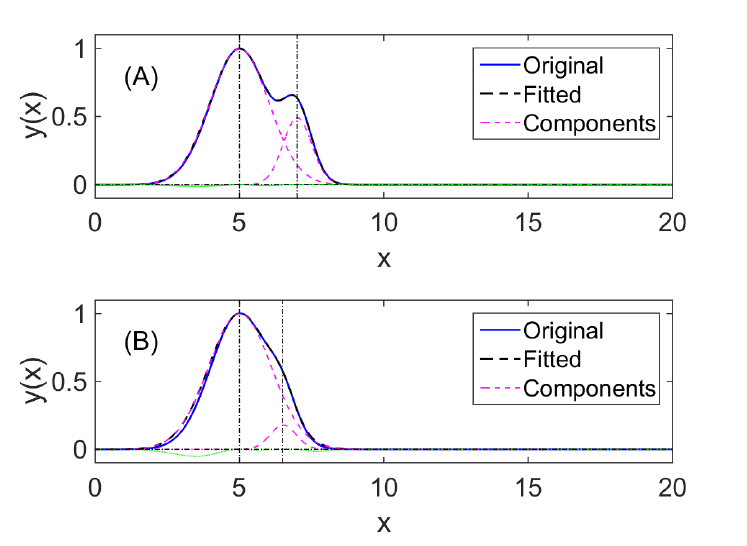
Figure 5. Original signals corresponding to Figure 3B,C (here the subpanels ( A , B ), respectively) shown as blue solid lines, their fitting by the series of Gaussian functions (black dashed lines) and the respective individual Gaussian components (magenta dashed lines). The green dotted curves close to zero demonstrate the residual between the original curve and its regression. Vertical dash-dotted lines indicate exact peak positions for individual components in the initial